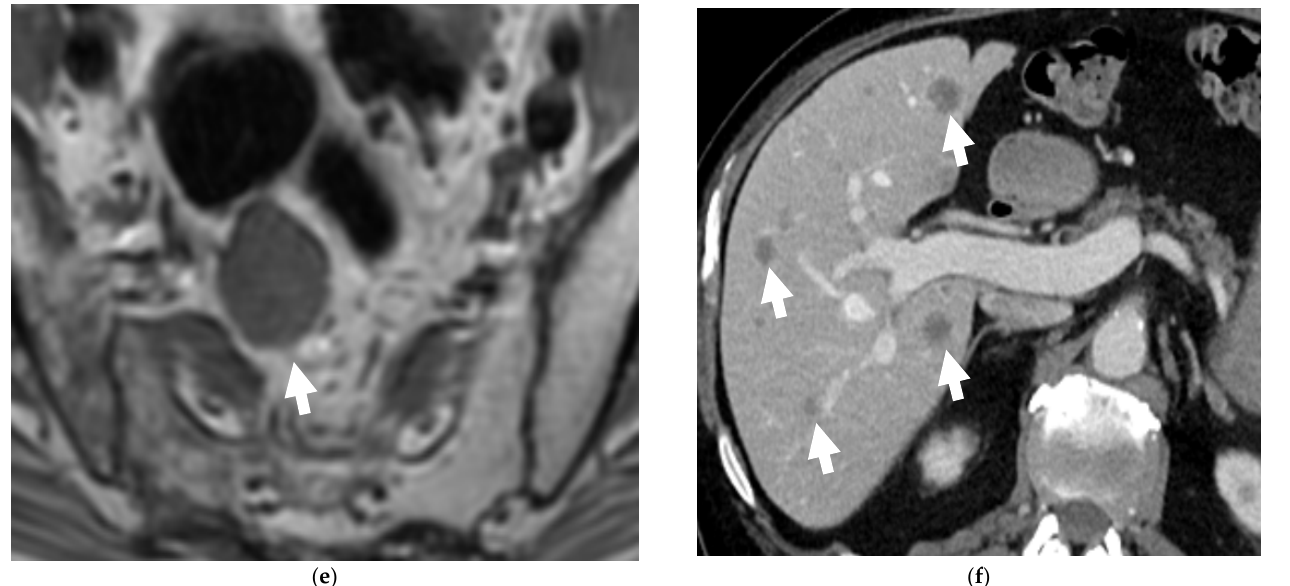
Figure 3. A 60-year-old male with Gleason 9 prostate adenocarcinoma at diagnosis, with later neuroendocrine differentiation after 1 year while on androgen deprivation therapy, with metastatic neuroendocrine prostate cancer. Axial ADC map of the MRI prostate ( a ) shows hypointense right prostatic nodule (with restricted diffusion), consistent with prostatic cancer (long arrow). There is a large mass along the right posterolateral aspect of the prostate, consistent with extraprostatic extension (short arrow). Axial T1W fast spin echo (FSE) image ( b ) shows bony metastasis involving the left posterior acetabulum. Patients’ serum PSA decreased following androgen deprivation therapy. Follow up MRI after 7 months revealed improving (smaller) extraprostatic component of the prostatic mass and left acetabular bony metastasis with relatively unchanged size of the prostatic neoplasm on the apparent diffusion coefficient (ADC) map ( c ) and axial T1W FSE ( d ) images. However, newly enlarged right presacral node (arrow) seen on T1W FSE ( e ) of follow-up MRI pelvis and multiple new liver lesions (arrows) seen on CECT ( f ) at 10 months and 18 months, respectively, after the diagnosis, were biopsied and proven to be metastatic adenocarcinoma with neuroendocrine differentiation.